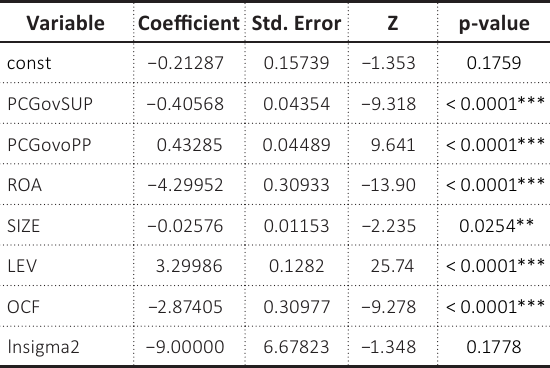
Table 4. Model 3, random effects probit